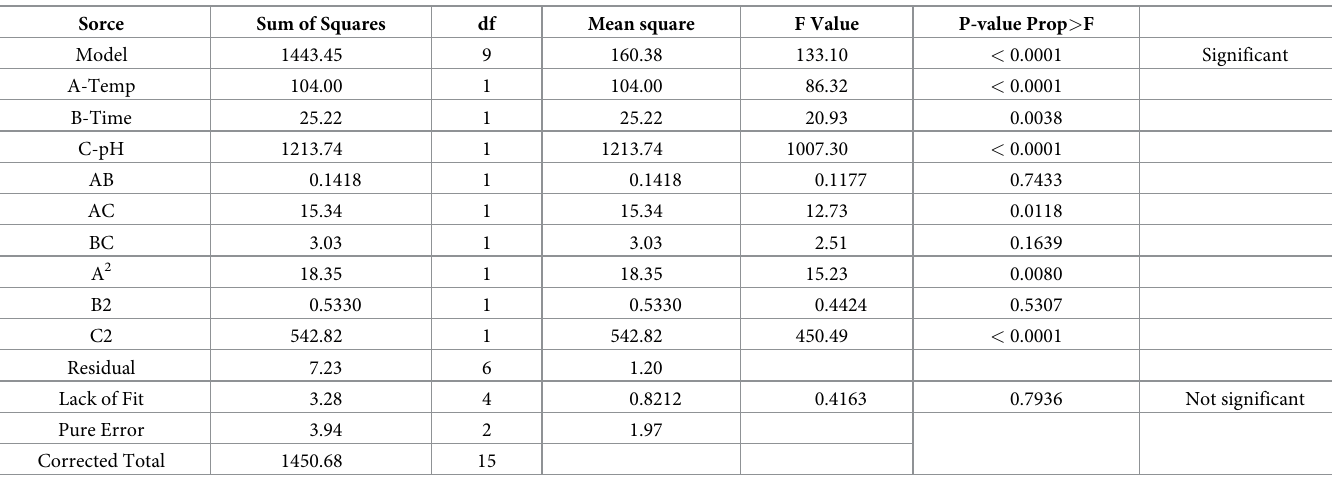
Table 6. ANOVA table for crystallinity (quadratic model).